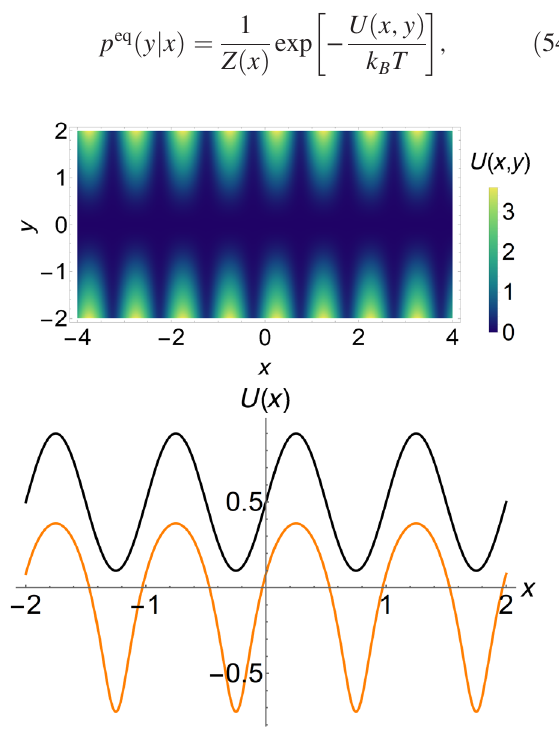
FIG. 5. The potential for the two-dimensional channel. Upper: the two-dimensional potential Eq. (53); lower, a section of the two-dimensional potential at y ¼ 1 (black) and the effective one- dimensional potential Eq. (57) (orange). The remaining param- eters are k ¼ 1 , L ¼ 1 , and α ¼ 0 . 8